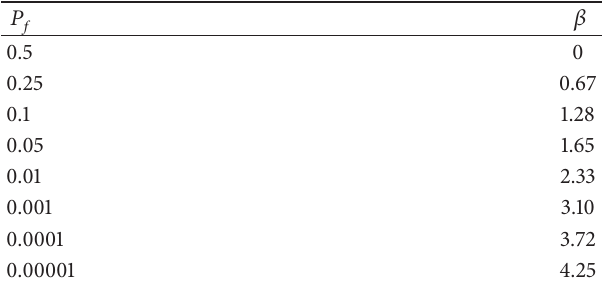
Figure 2: Location of Zhaoshuling